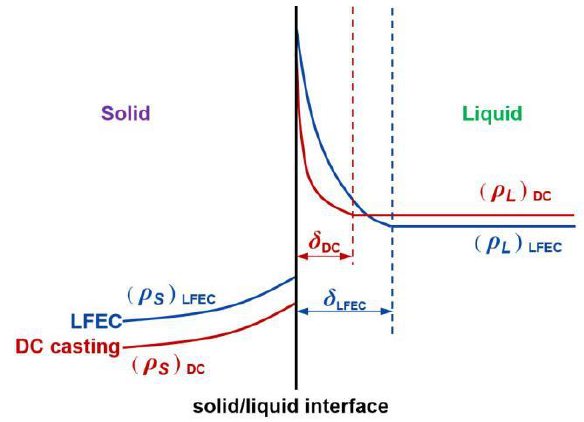
Figure 14. Distribution of alloying element in area of solid/liquid interface.